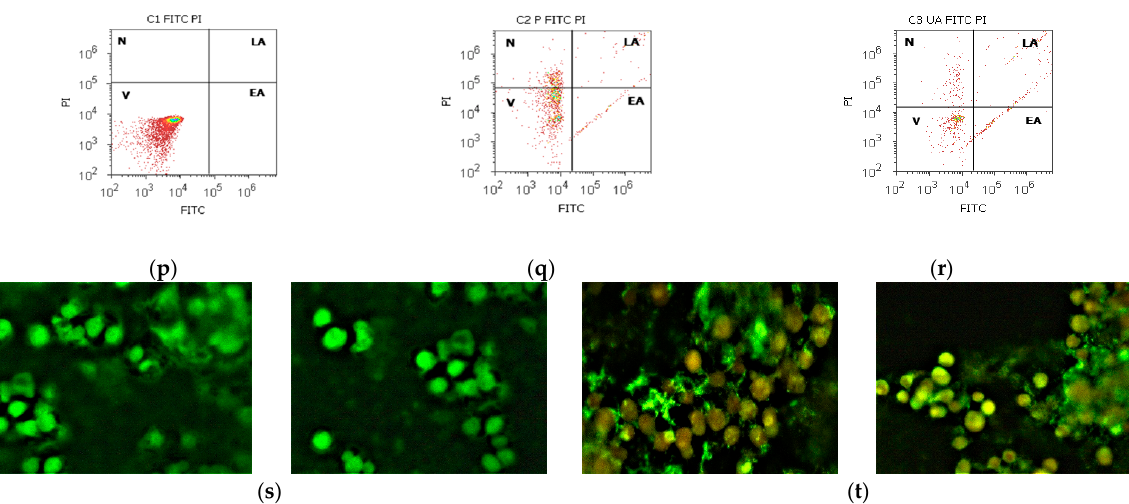
Figure 3. Apoptosis in blood cells ( a – c , g – i , m – o ) and CLS-354 tumor cells ( d – f , j – l , p – r ) after 24 h exposure to different concentrations [3:3; 3:2; 3:1] of U. barbata extract in canola oil (UBO) ( a – f ) and canola oil (CNO) ( g – l ) compared to C1, C2P, and C3UA controls ( m – r ). C1—1% DMSO (negative control), C2P—5% Poloxamer 407 (positive control), C3UA—usnic acid (positive control), V— viability, EA—early apoptosis, LA—late apoptosis, N—necrosis. [3:3; 3:2; 3:1]—culture medium/sample ratio ( v/v ); FM images of tumor cells stained with Annexin V-FITC/PI ( s , t ): viable (unstained) and early apoptotic cells—green stain ( s ); late apoptotic cells mixed with necrotic ones—green membrane with dark orange fragmented nuclei ( t ).